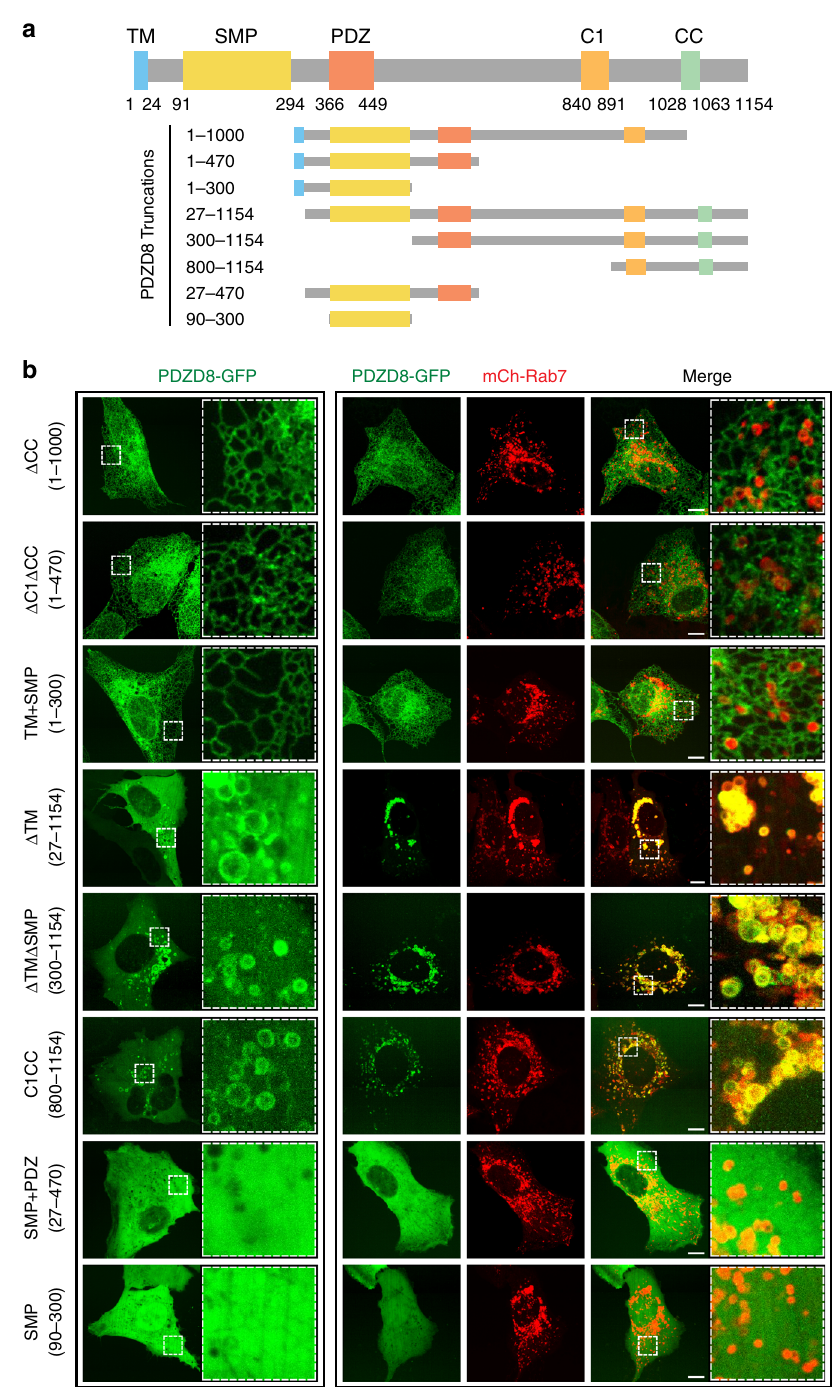
Fig. 3 The PDZD8 C1 and CC domains are suf fi cient for recruitment to Rab7-endosomes. Domain analysis of the interaction of PDZD8 with Rab7- endosomes. a Schematic diagram depicting PDZD8 domain structure. TM transmembrane, SMP synaptotagmin-like mitochondrial lipid-binding proteins, PDZ postsynaptic density protein (PSD95), Drosophila disc large tumor suppressor (DlgA) and Zonula occludens-1 protein (ZO-1), C1 protein kinase C conserved region 1, CC coiled-coil. b GFP-tagged truncated versions of PDZD8 that were analyzed. Representative images of U2OS cells expressing GFP- tagged truncated versions of PDZD8 alone (left panel) or with mCherry-Rab7 (right panel). Scale bar: 10 μ